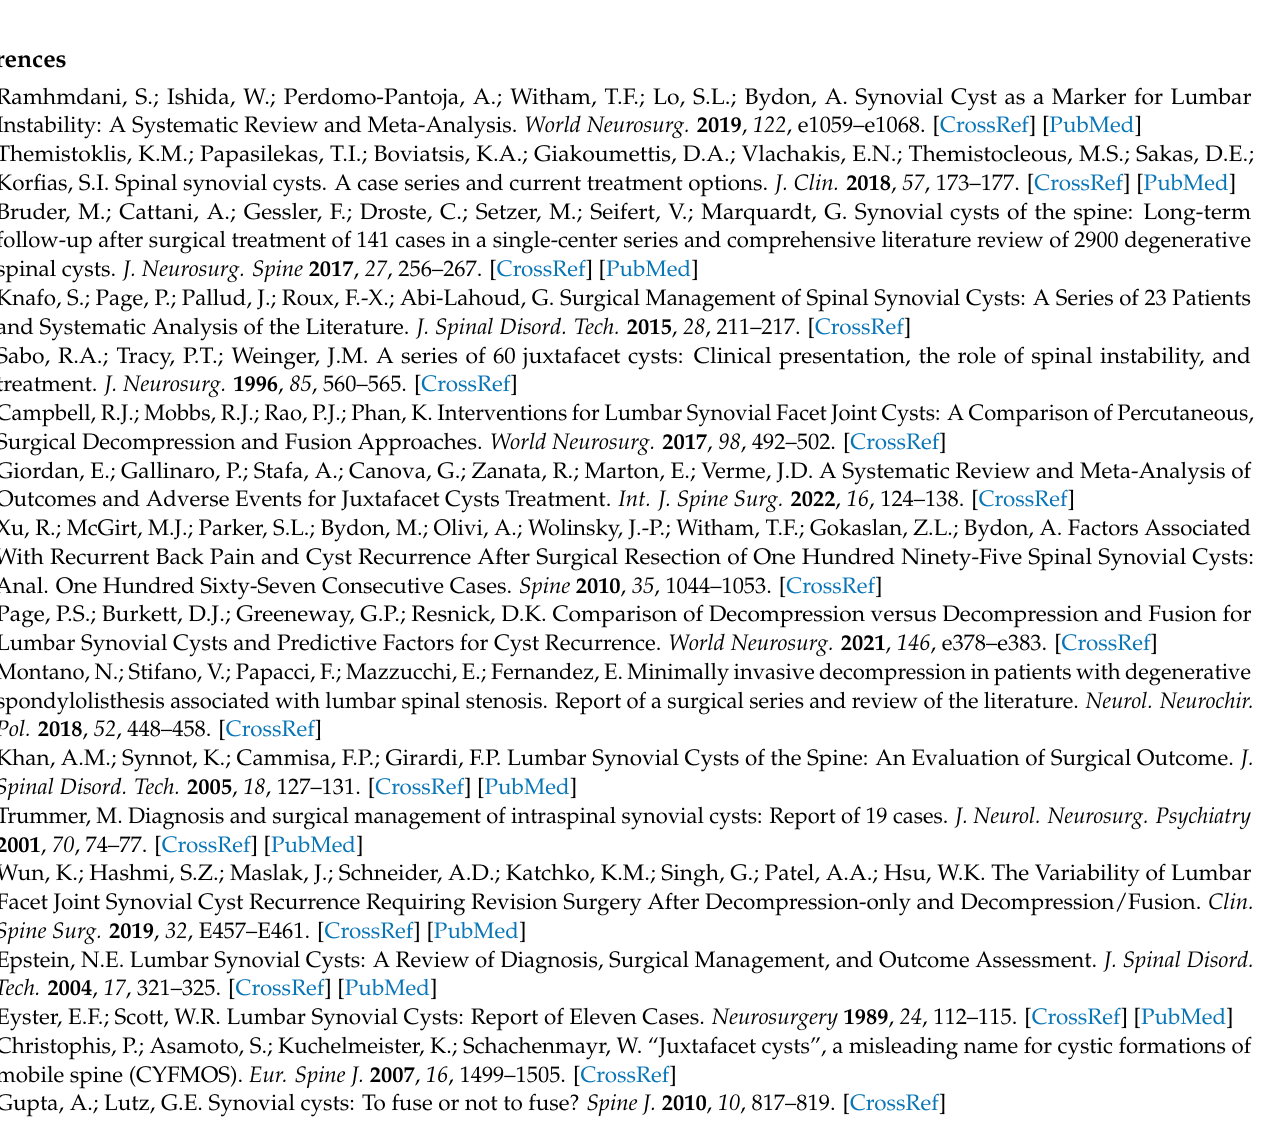
Figure A14. Length of stay.